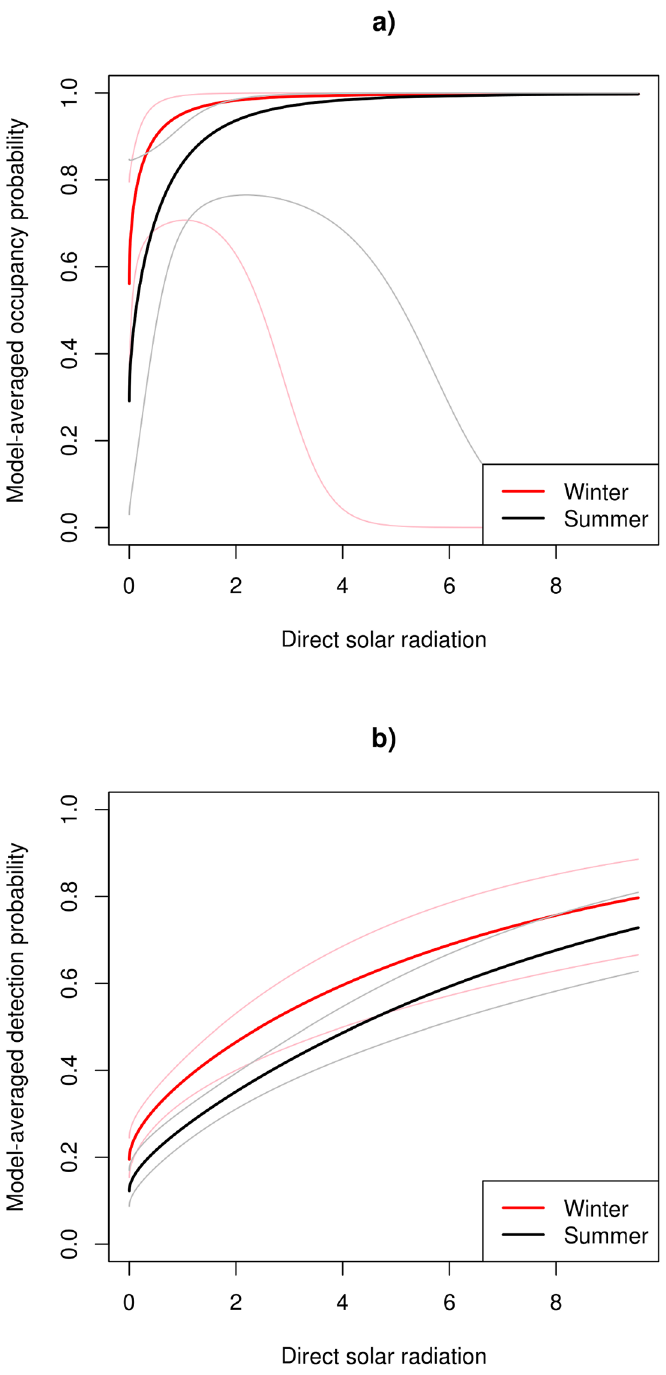
Fig 4. Seasonal model-averaged occupancy (a) and detection (b) probabilities for rusa deer versus direct solar radiation. Direct solar radiation (total mols m -2 day -1 ) refers to that transmitted through the canopy. Lighter lines indicate 95% confidence